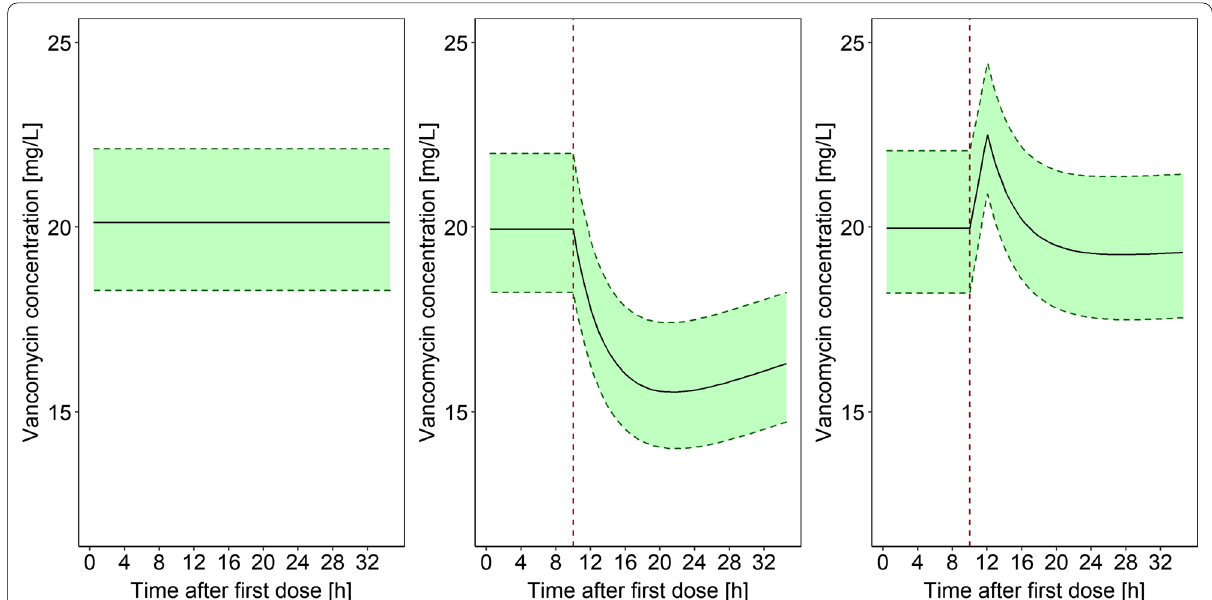
Fig. 3 Predicted (n 3000) vancomycin pharmacokinetic plasma profile during continuous infusion. Left: without CytoSorb ® . Middle: with = CytoSorb ® installation after 10 h and no additional vancomycin dose. Right: with CytoSorb ® installation after 10 h and an additional vancomycin dose of 500 mg over 2 h. For all scenarios, a continuous infusion of 46 mg/h was administered. Black line: median prediction, Green shade: 50% prediction interval, red vertical line: insertion of the CytoSorb